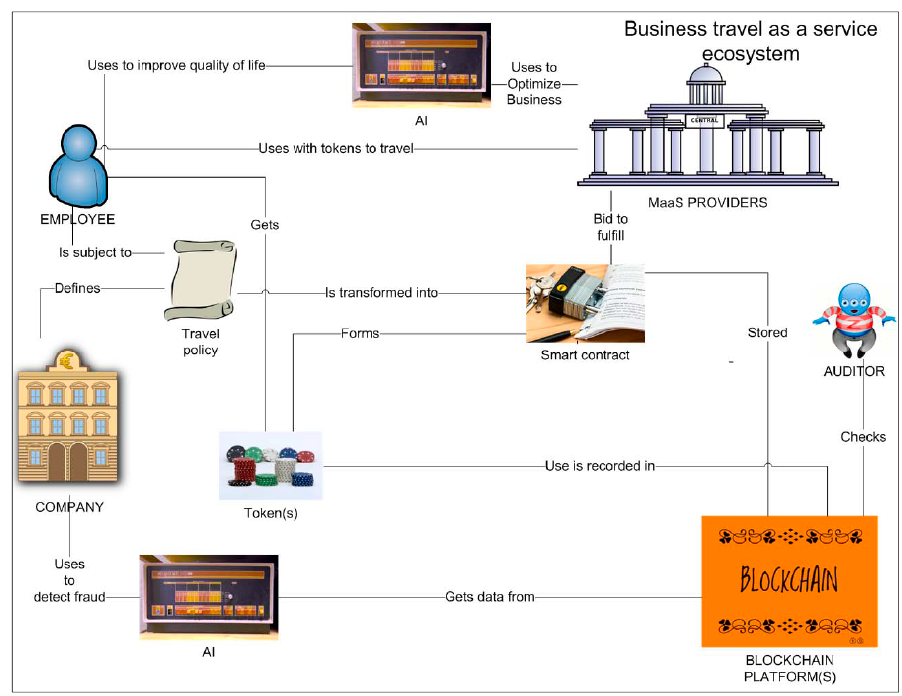
Figure A1. The blockchain-enabled MaaS ecosystem. Reproduced from Karinsalo et al. [13] (p. 137).